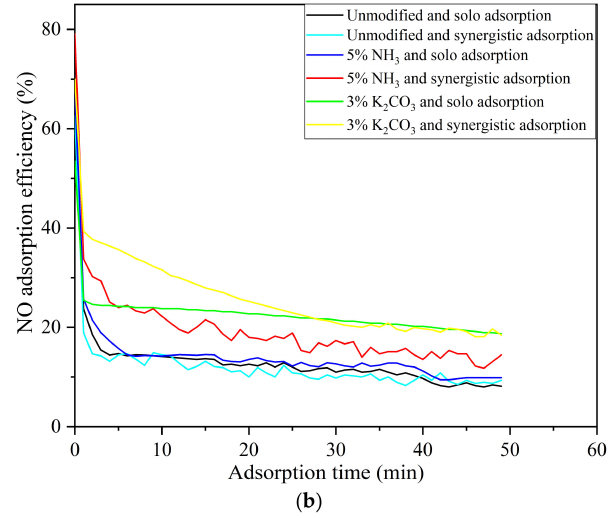
Figure 6. Solo and synergistic adsorption efficiencies of activated coke with different modifications. ( a ) The adsorption efficiency of SO 2. ( b ) The adsorption efficiency of NO.